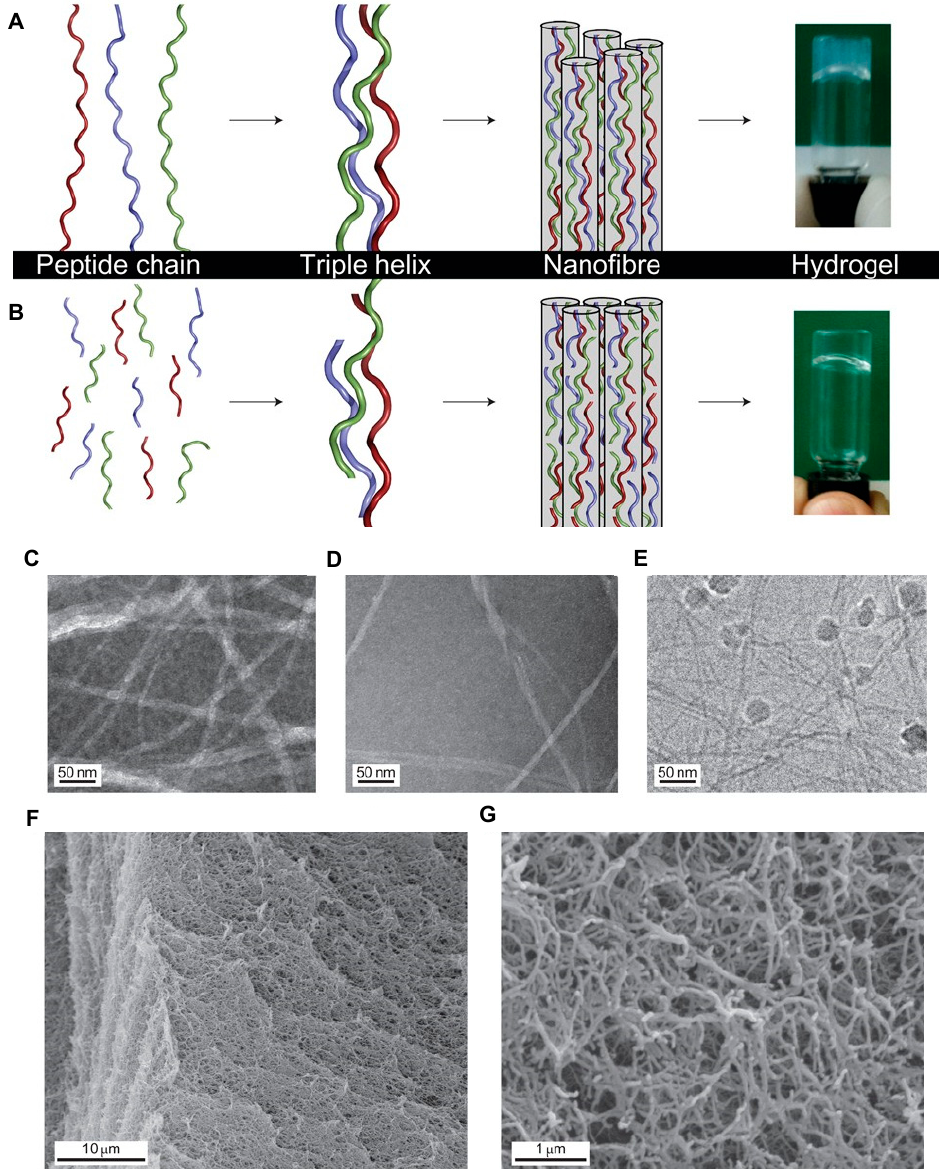
Figure 2. ( A ) Type I collagen assembly in which the peptide chains (shown in red, blue and green), consisting of ~1000 amino acids, form triple helices ~100 nm in length and the blunt-ended nanofibres (shown in grey) assemble via the staggered lateral packing of the triple helices. The hydrogel pictured represents rat-tail collagen. ( B ) Self-assembly of collagen mimetic peptides, in which the peptides consist of 36 amino acids (shown in red, blue and green), form a triple helix staggered with a length of 10 nm and the nanofibres (shown in grey), and result from triple helical elongation, as well as from lateral packing. The hydrogel depicted is the synthetic peptide (Pro-Lys-Gly) 4 (Pro-Hyp-Gly) 4 (Asp-Hyp-Gly) 4 . ( C – E ) Transmission electron microscopy (TEM) images of collagen-like nanofibres taken at × 40,000. ( F , G ) Scanning electron microscopy (SEM) images of critical-point dried hydrogel with a peptide concentration of 1.0% by weight that shows the interconnected fibrous structure responsible for the gel forming properties at × 3100 ( F ) and × 30,000 ( G ). Adapted with permission from O’Leary et al. 2011 Copyright Nature publishing